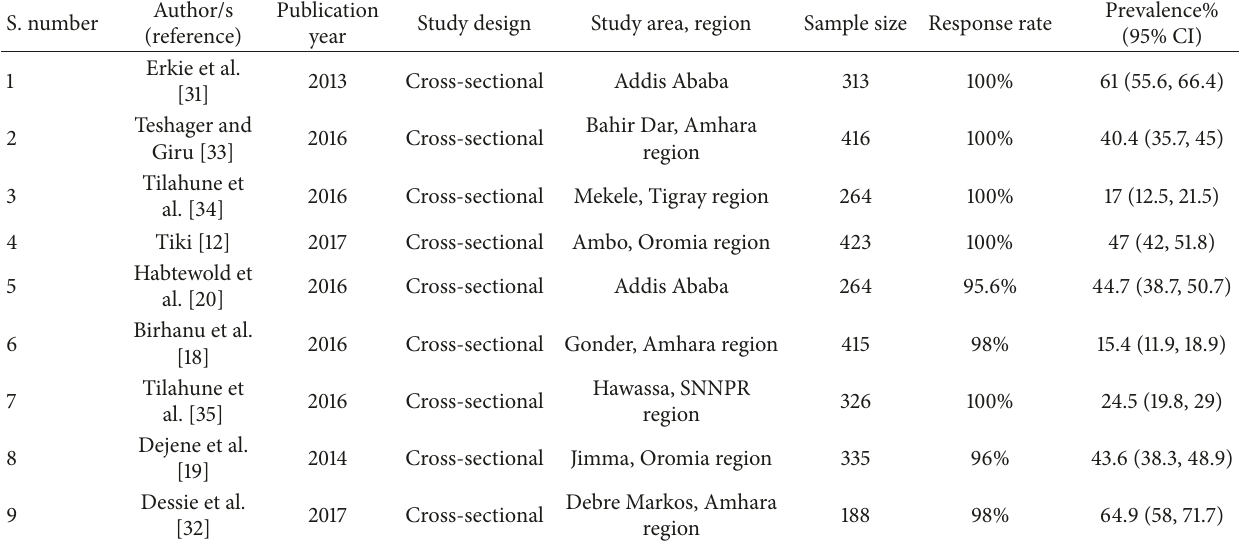
Table 1: Characteristics of studies included in meta-analysis of the prevalence of depression among diabetic patients in Ethiopia, 2018. S. number